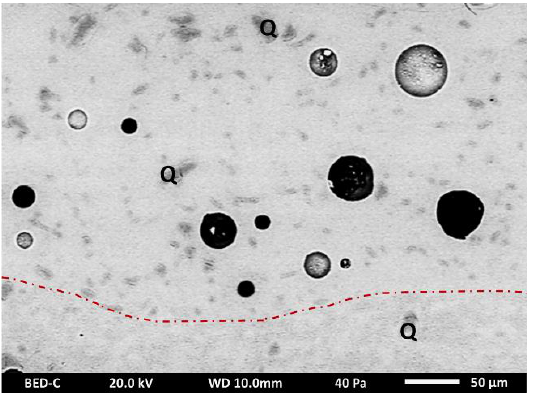
Figure 7. SEM backscattered electron images of porcelain glaze; the presence of quartz (Q) in the glaze (at the top of the red dotted line) and in the body (at the bottom of the red dotted line).